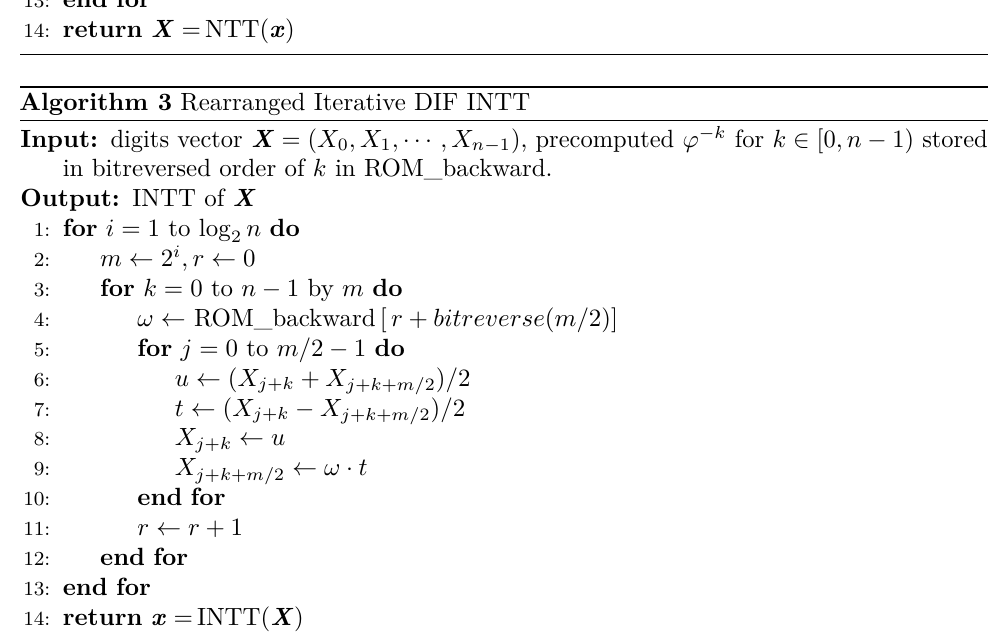
Algorithm 3 Rearranged Iterative DIF